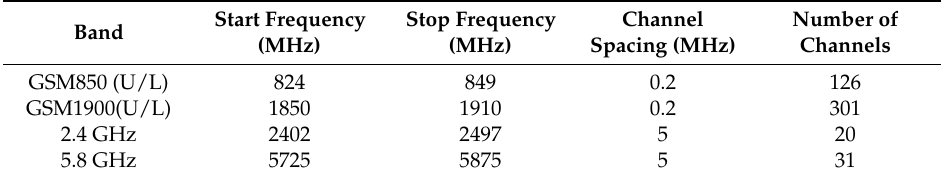
Table 2. List of bands and channels.